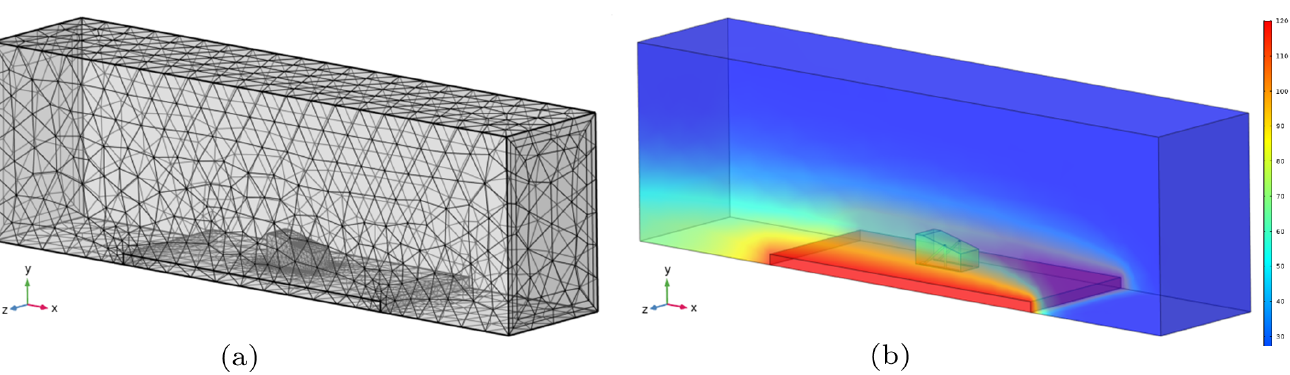
Figure 3. Heat transfer model in COMSOL: ( a ) Finite element mesh created for model solution; ( b ) Frame of the temperature distribution taken in the simulation time of 2.5